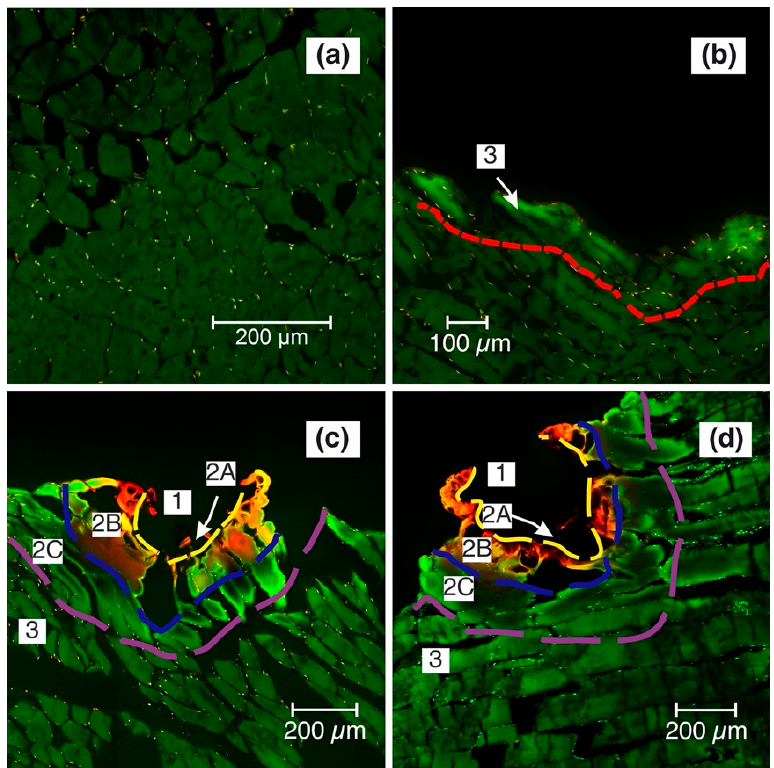
Figure 4. Section of porcine longissimus muscle tissue ( a ) before exposure; and after 30 s exposure by Ho-doped fiber laser systems operating in ( b ) CW mode with a power of 0.3 W (applied energy of 9 J) [41]; ( c ) USP mode with a power of 0.3 W (applied energy of 9 J); ( d ) CW mode with a power of 0.5 W (applied energy of 15 J) [41]. 1—Ablation zone (AZ), 2—Coagulation zone (CZ) with the elements of the coagulation crust and fragmentary charring, 3—Heat-affected zone (HAZ).